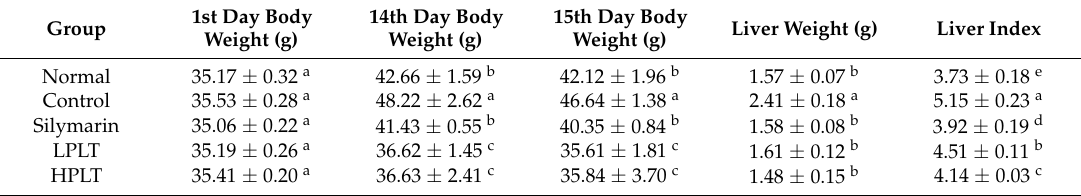
Table 4. Body weight, liver weight, and liver indices in experimental mice with CCl 4 -induced hepatic damage.